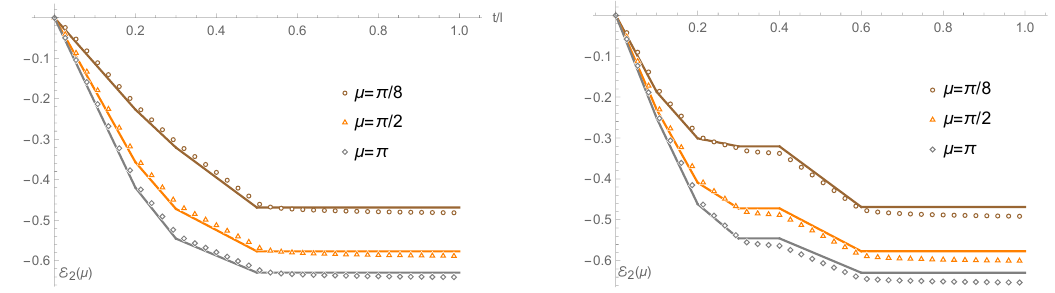
Figure 1 . Numerical data of charged Rényi logarithmic negativity E 2 ( µ ) as a function of t/l for µ = π , π , π in the complex harmonic chain. The full lines are the CFT predictions (cf. eq. (4.9) and 8 2 eq. (4.14)). Left panel: adjacent interval with L = 3000 , l 1 = 200 , l 2 = 300 . Right panel: